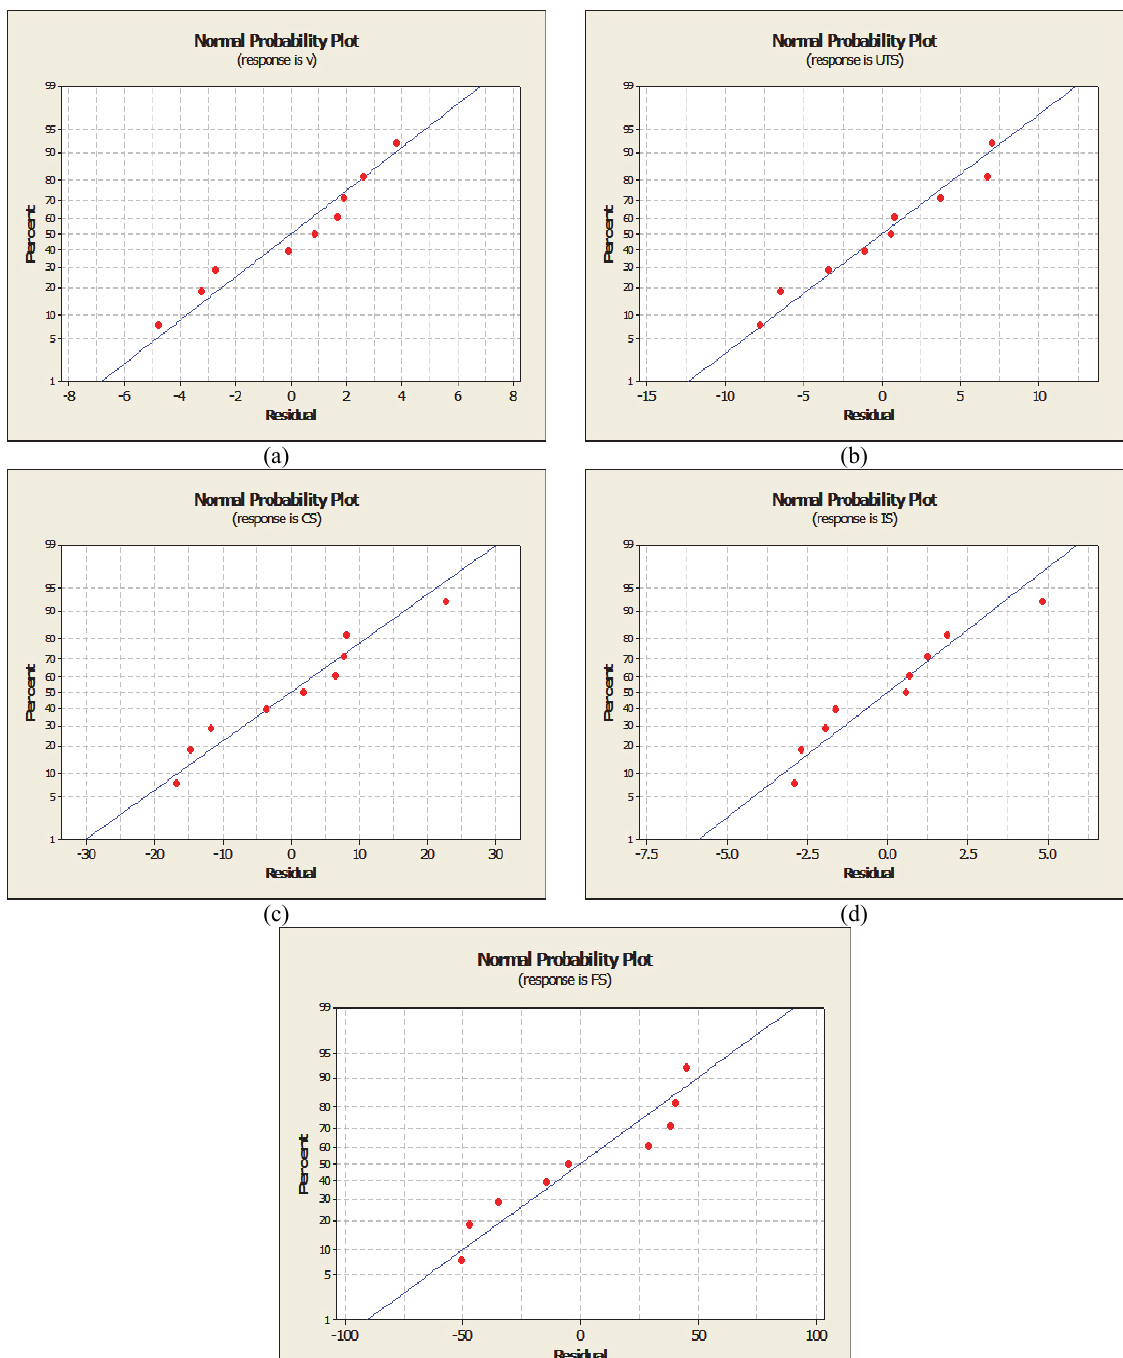
Fig. 8. Normal probability plots of residuals for (a) v; (b) σ ut ; (c) σ c ; (d) σ i ; and (e) σ